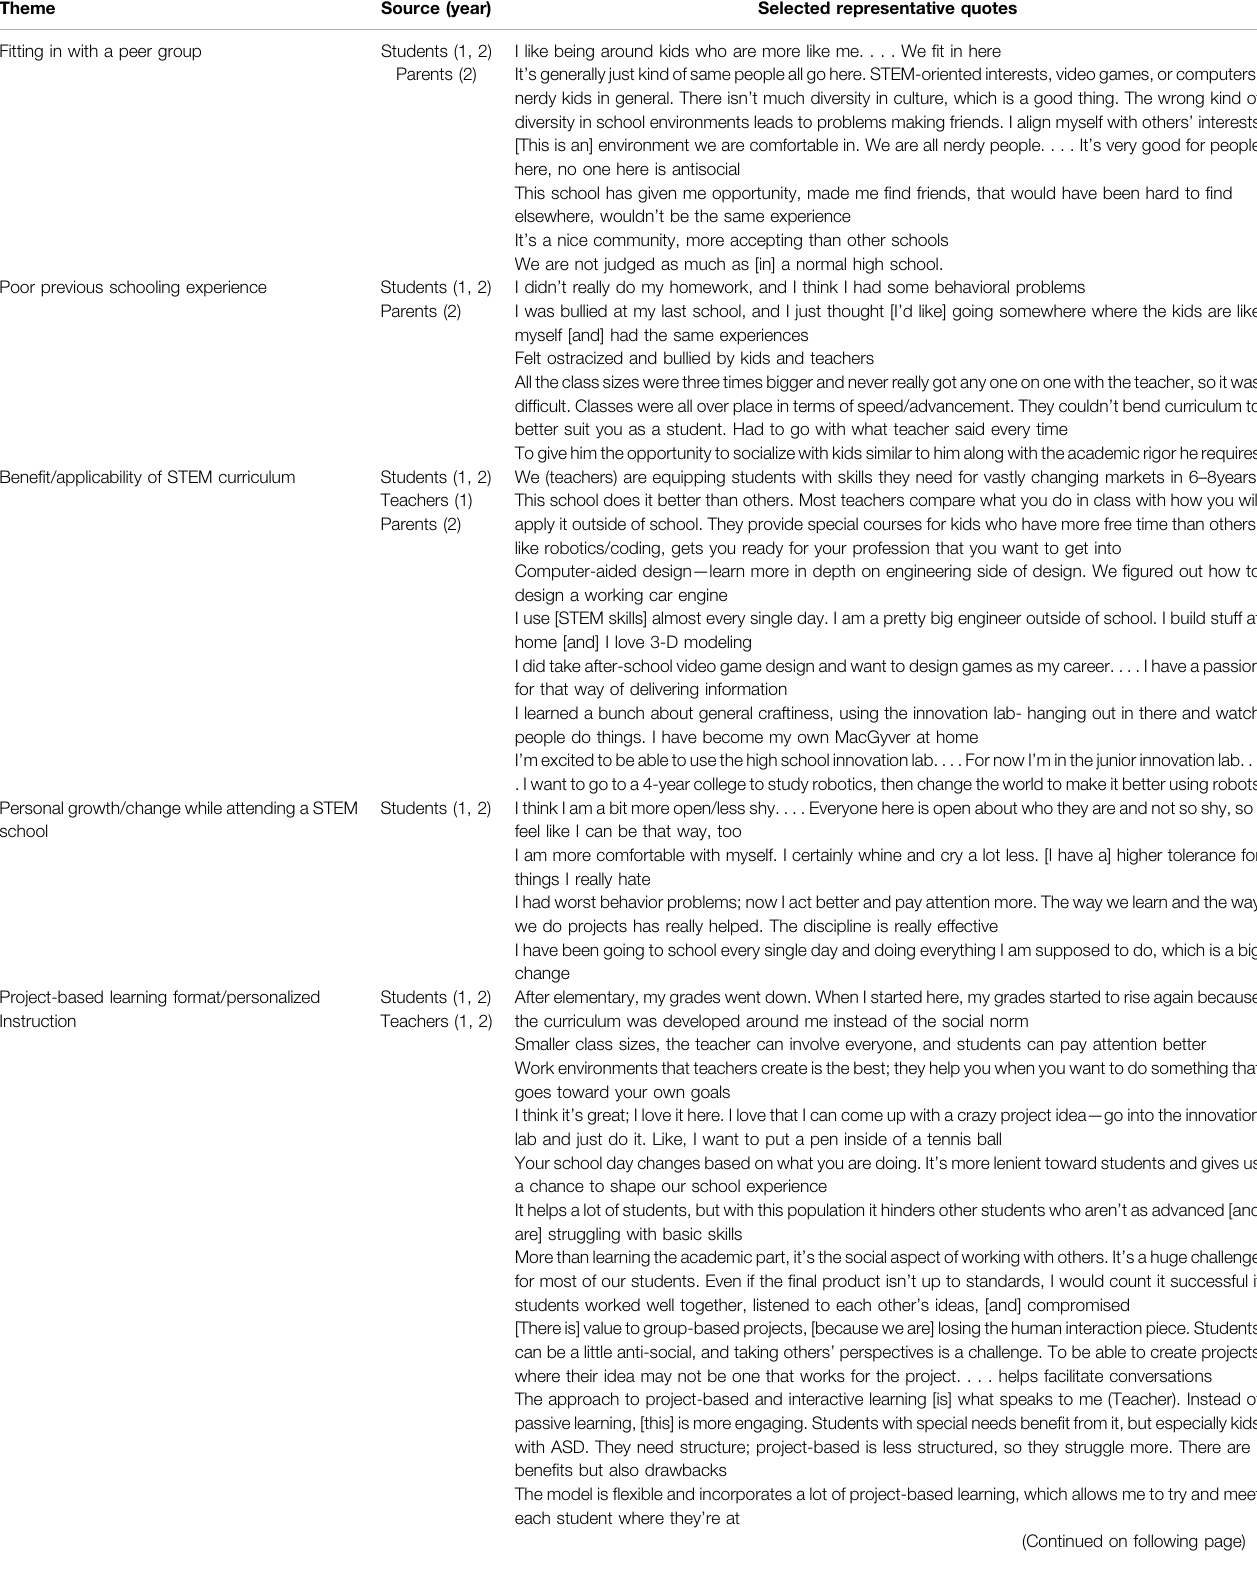
TABLE 4 | Themes from parent surveys and student and teacher interviews on STEM school